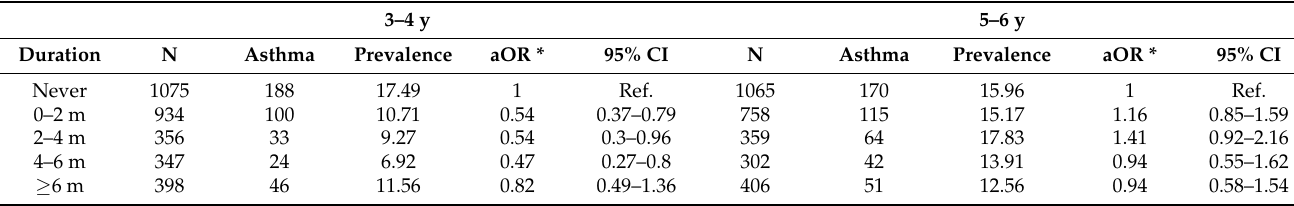
Table 3. Association of exclusive breastmilk feeding duration with risk of asthma by age. 3–4 y 5–6 y